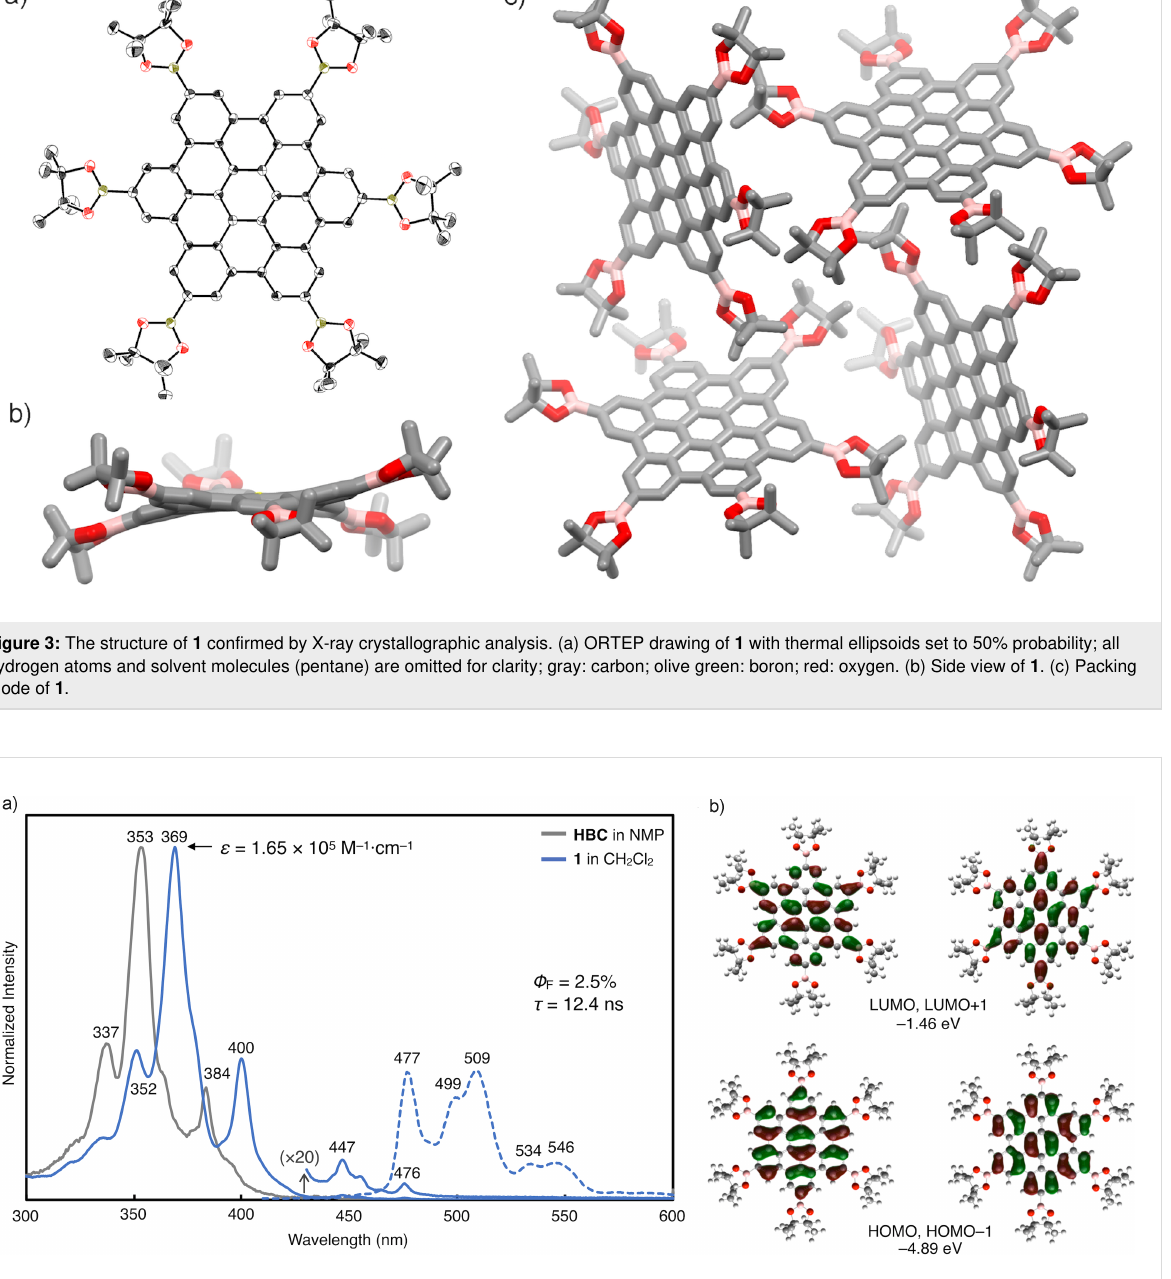
HBC, the characteristic three peaks of the HBC core were red- shifted about 15 nm for 1 . The molar absorption coefficient ( ε ) at the maximum absorption wavelength of 1 (369 nm) was 1.65 × 10 5 M − 1 ·cm − 1 . The maximum absorption peak and the minimum fluorescence peak were nearly overlapped, which in- dicated that these peaks can be assigned to 0–0 transitions. The